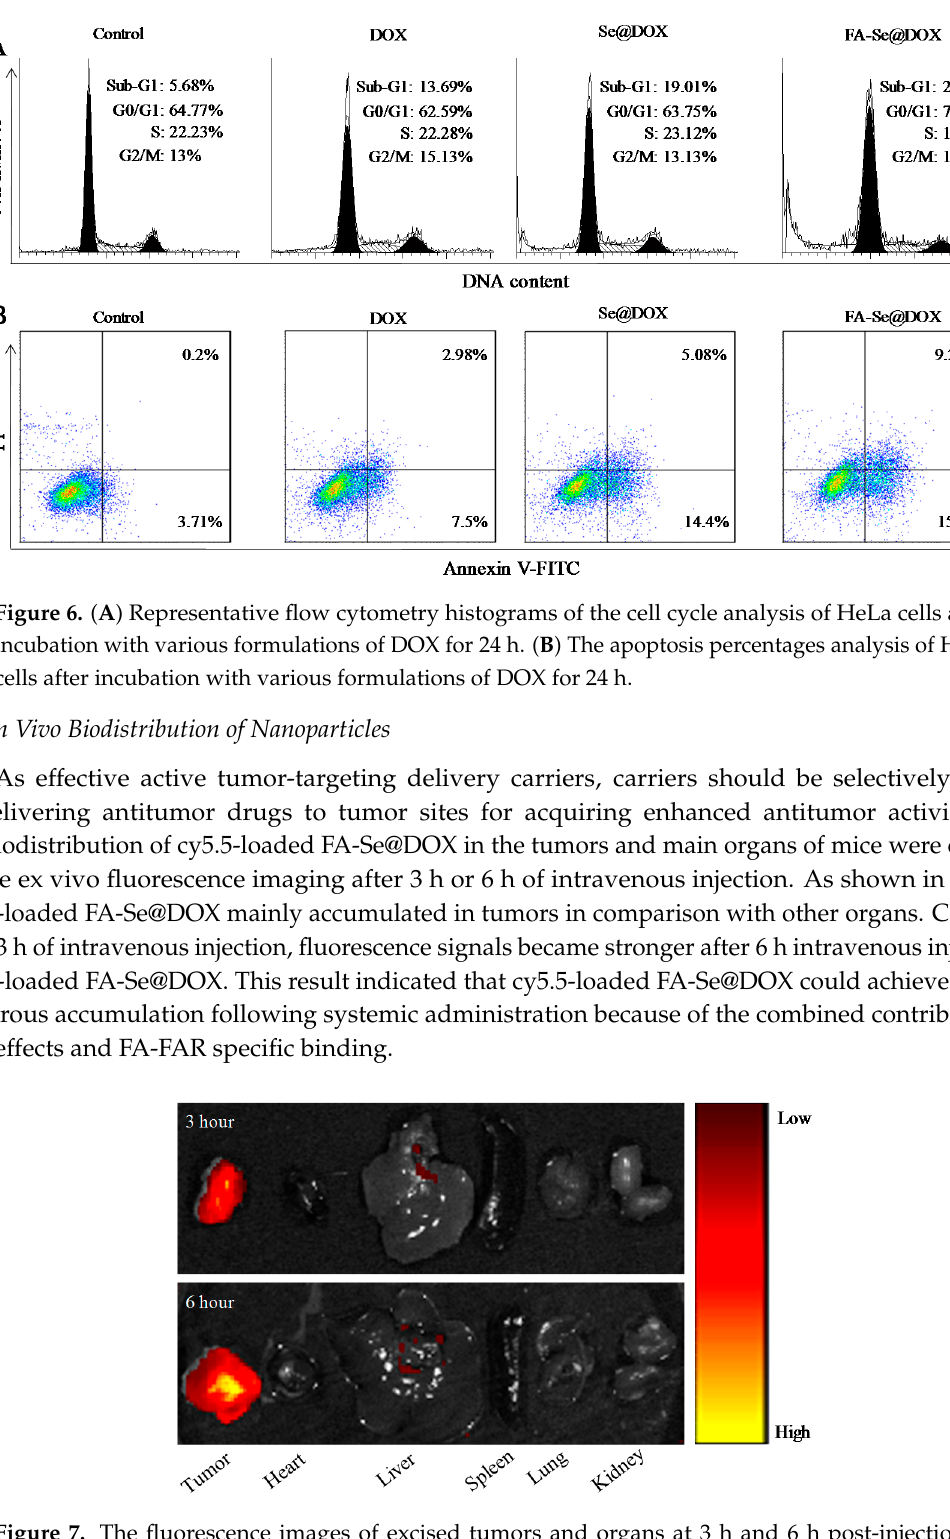
Figure 7. The fluorescence images of excised tumors and organs at 3 h and 6 h post-injection of FA-Se@DOX, respectively.